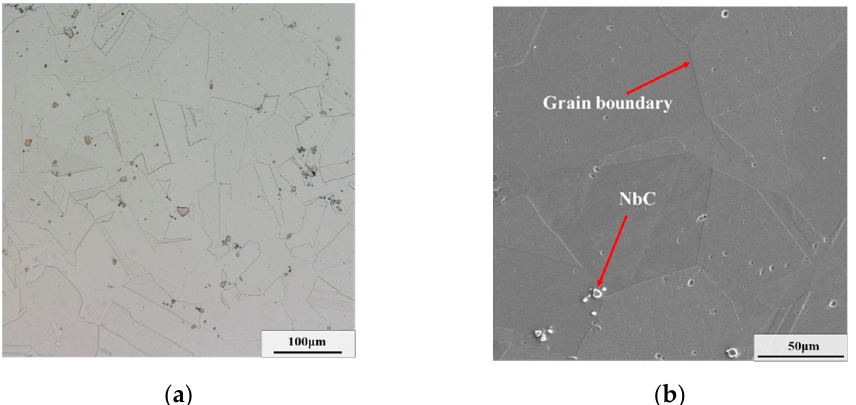
Figure 1. Microstructure of GH4169 superalloy after the solution treatment: ( a ) OM map; ( b ) SEM map.